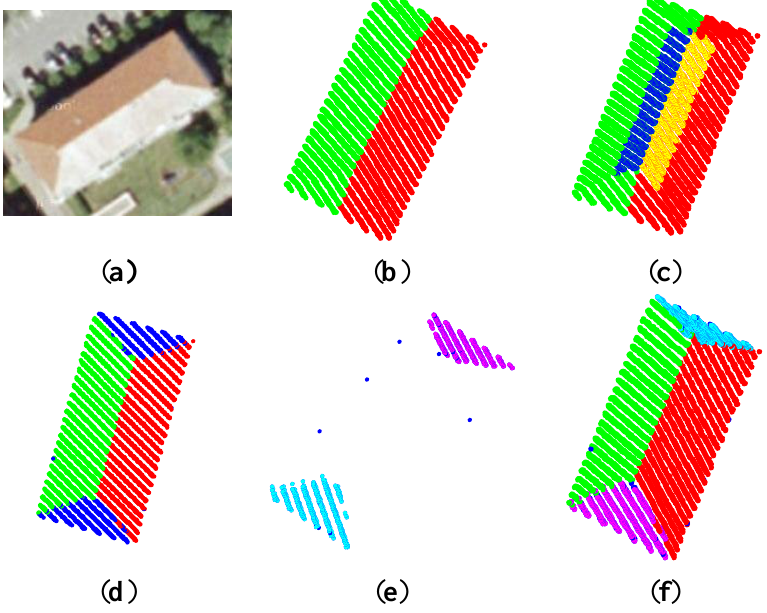
Figure 2. Segmentation of a simple gabled roof (hipped roof as a special case). ( a ) Aerial photo from Google Map. ( b) divided by ridge plane into two groups . ( c ) Seed planes along the roof ridge. ( d ) segmentation along roof ridge. (e) Segmentation of rest points. ( f ) final